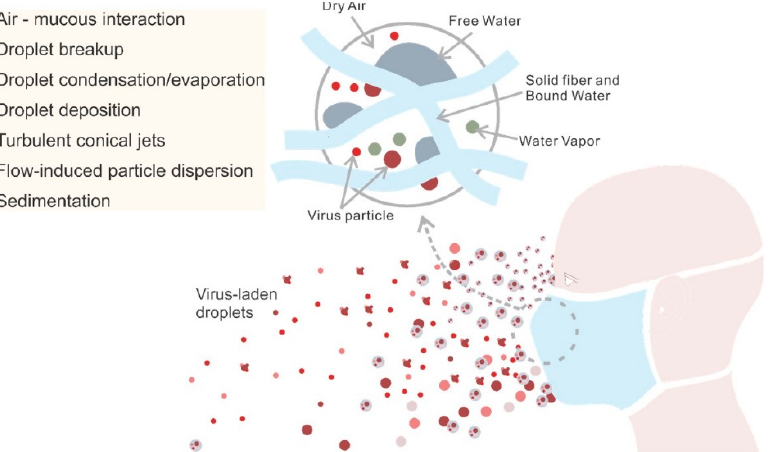
Figure 4. Schematic to illustrate the transport processes of virus-laden droplets in the human-mask-environment system.